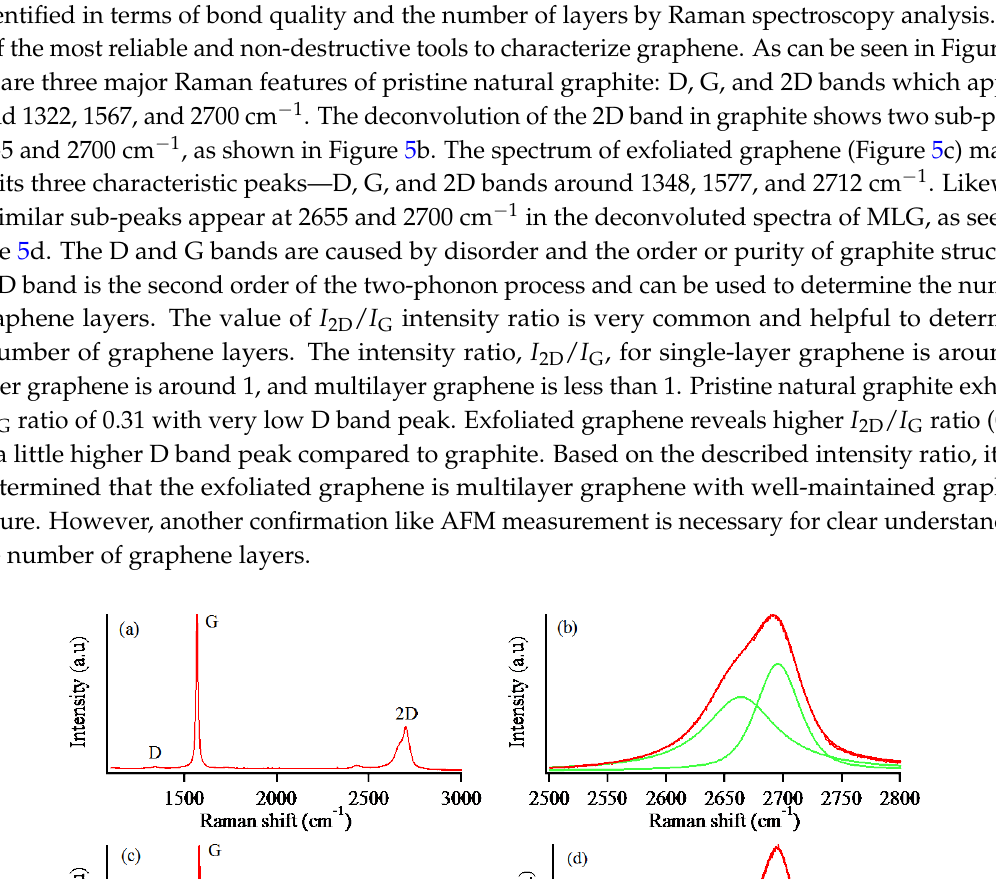
Figure 4. SEM images of ( a ) pristine graphite; ( b ) exfoliated graphene